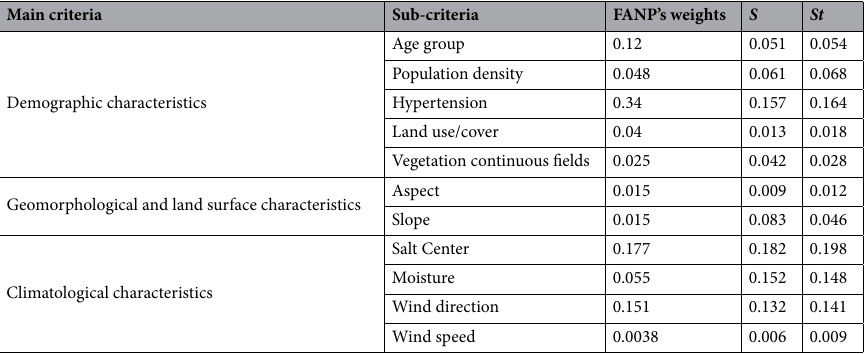
Table 4. Results of criteria weighting using the Fuzzy Analytical Process and sensitivity analysis based on the Monte Carlo and Global Sensitivity Analysis to validate the obtained indicator weights for vulnerability and health risk